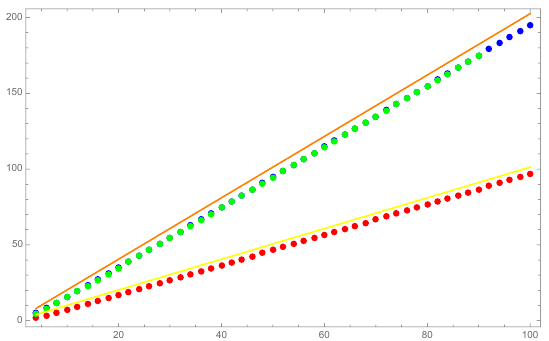
Figure 4. Plot of matching digits between results from linear combination and from Fourier trans- formation against Q = 2 (cid:25)=(cid:30) for various 2-instanton events. Blue, red, and green (indistinguishable from blue) dots correspond to E II ; E II mix , and E pert + E I (cid:22) I respectively. Also plotted in yellow 0 0 0 0 (orange) line is log of 2-(4-)instanton action 2 A=(cid:30) (4 A=(cid:30) 10